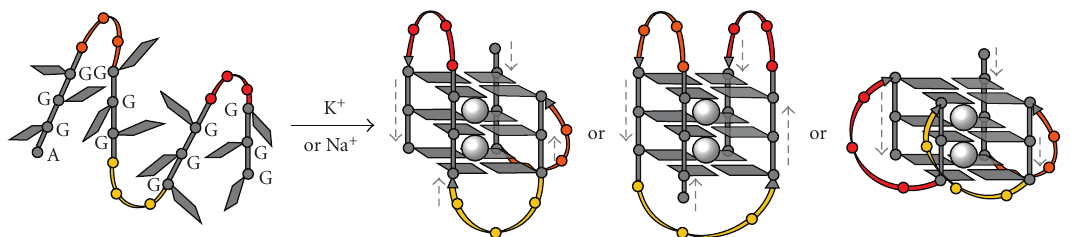
Figure 1: Schematic representation of the folding of an oligonucleotide that mimics the human telomeric sequence (d[AG 3 (T 2 AG 3 ) The polymorphism of the quadruplex is represented through the various possible structures, namely, the hybrid (left), antiparallel (centre), and parallel (right) forms; these structures di ff er by strand orientation (grey dashed arrows) and loop arrangement (represented in orange, yellow, and red).